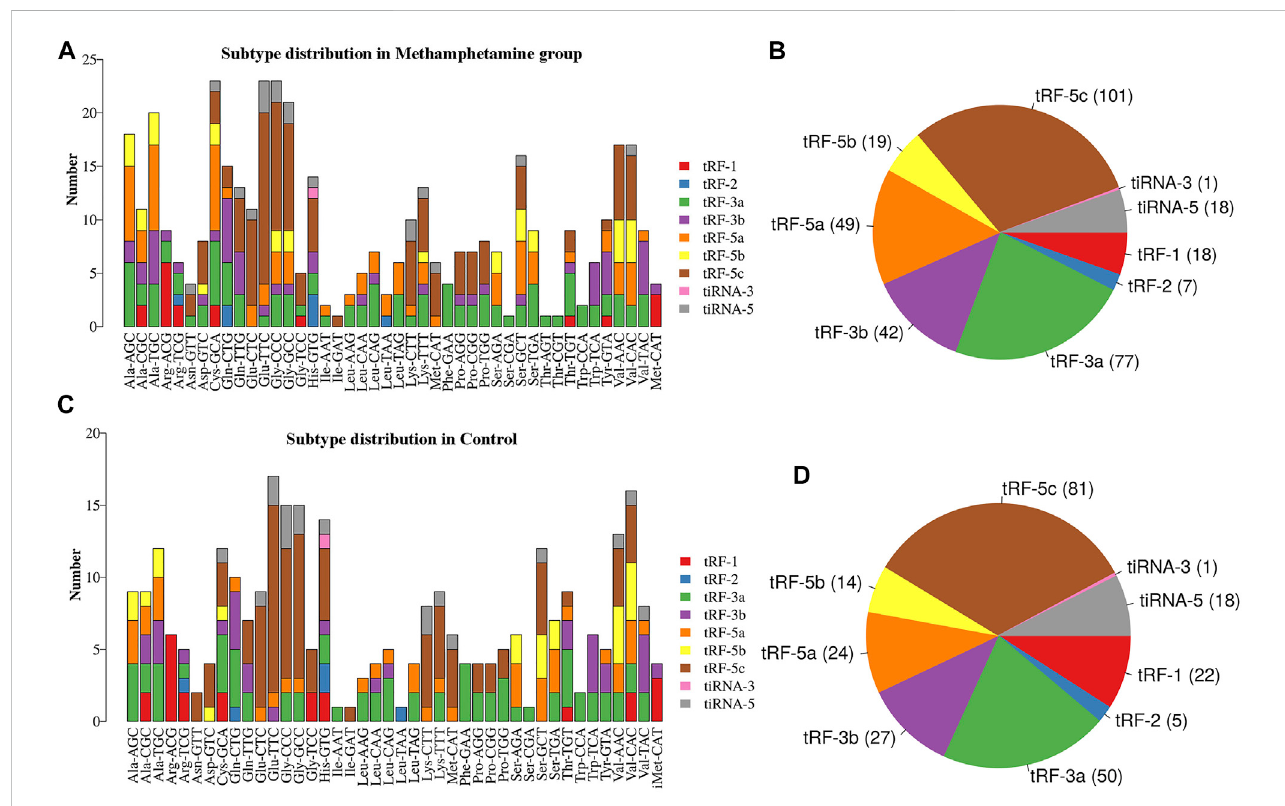
The distribution of tRF and tiRNA subtypes and the number of tsRNA subtypes against tRNA isodecoders. (A) and (B) Subtype distribution in methamphetamine self-administration rats. (C) and (D) Subtype distribution in saline control rats. tiRNA: tRNA half, tRF: tRNA-related